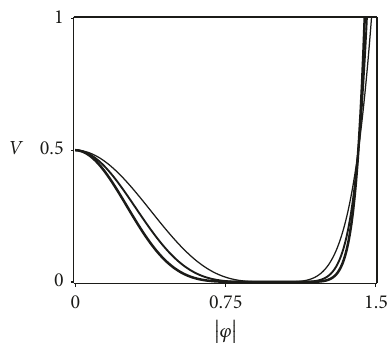
Figure 2: The potential in (31) for 𝑠 = 4 , 𝑠 = 6 , and 𝑠 = 8 . The thickness of the lines increases with 𝑠 .